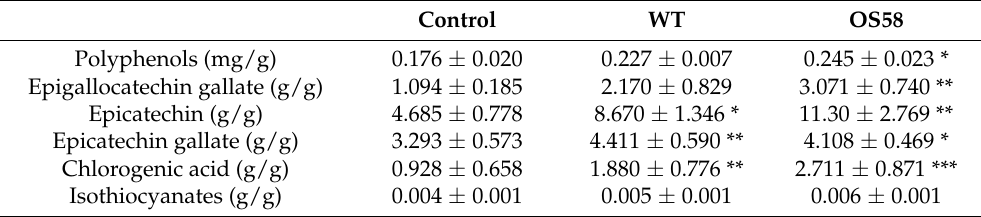
Figure 2. The total polyphenols content (calculated as mg per gram of fresh cauliflowers, before freezing) is reported for Control, WT, and OS58 groups as estimated means and 95% confidence intervals (larger dots and colored lines, respectively) by the linear mixed model (LMM). On the upper side of the plot, treatment effects are reported in mg/g as the estimated means and 95% confidence intervals for each comparison, as difference from the control or between enzymatic treatments, as indicated on the left (degrees of freedom-df = 10.7). The level of significance ( p -value) is reported above each horizontal line; the dashed line corresponds to the “no effect” hypothesis. The values reported were obtained from the model using the emmeans package (n = 4, for each group) [17]. Table 1. The concentration of secondary metabolite extracted (mg or μ g per gram of fresh cauliflower) for each pretreatment group [control = sterile medium; WT = spent medium from the WT strain; OS58 = spent medium from the optimized strain].